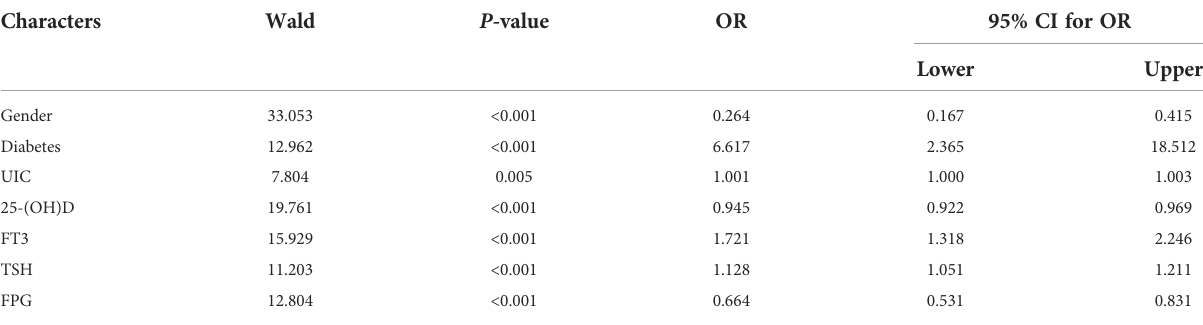
TABLE 2 Logistic regression analysis on risk factors for